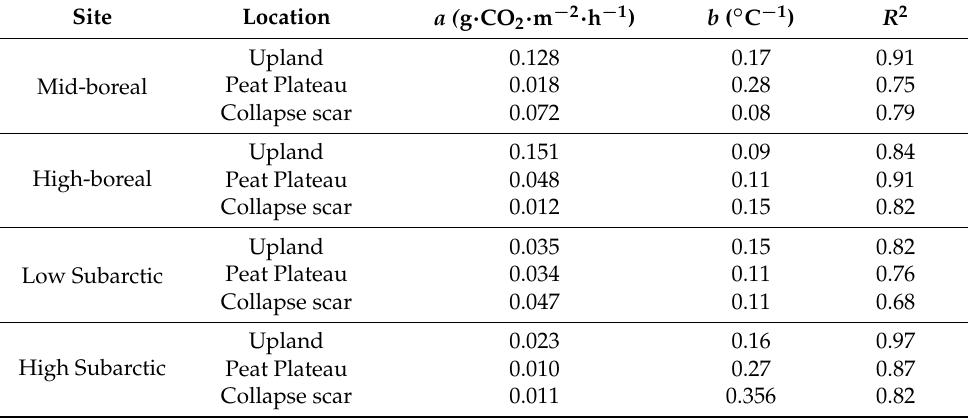
Table 2. Parameter values to estimate the effect of soil temperature T ( ◦ C) at the 5-cm depth on net for landforms across different ecoregions